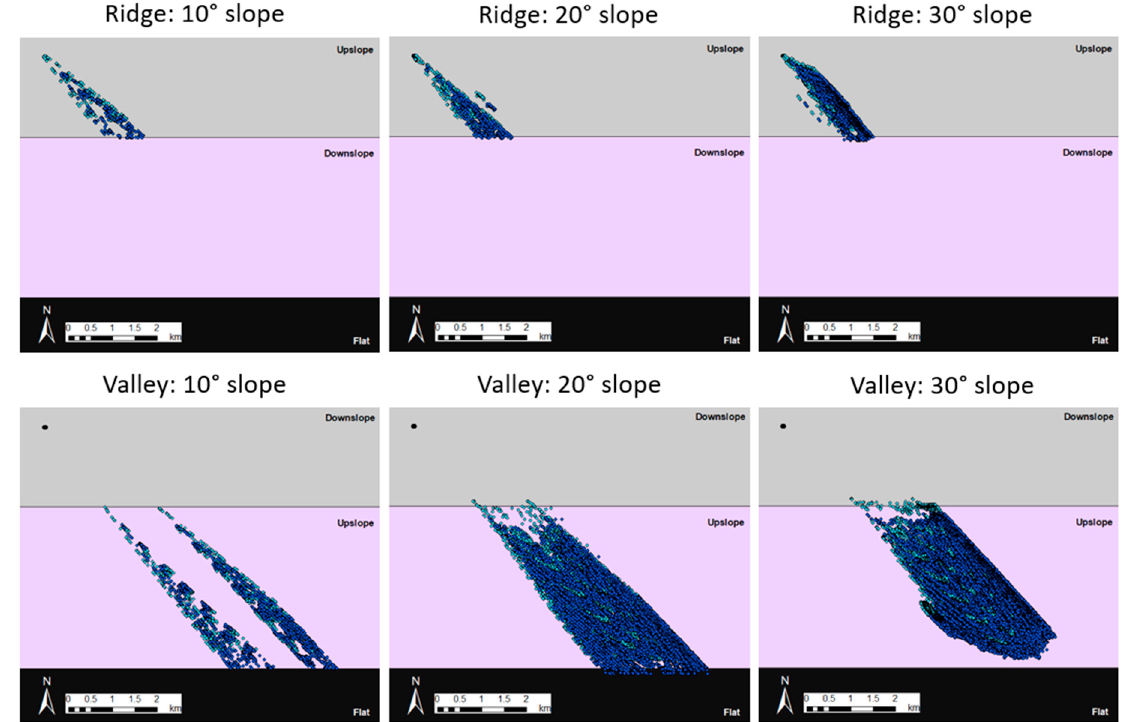
Figure 9. Spotting launch (light blue) and land (dark blue) locations on an idealized east-west oriented ridge (top) or valley (bottom) with differing slopes from the same ignition point (black dot in upper-left corner). Constant 13.41 m/s (30 mph) NW (315°) winds were applied. The fuel map used was all FM15 (chamise), although results are consistent with other fuel models tested such as FM1 (grass) and FM16 (ceanothus).